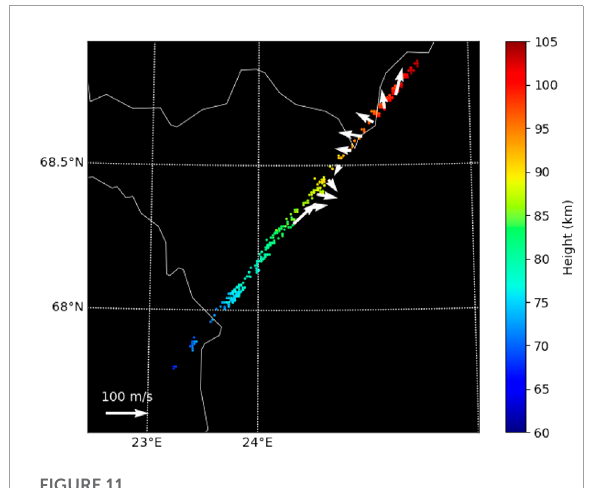
FIGURE 11 The horizontal wind estimated from the long-lasting trail echo, overlaid on the locations of the trail map. The color indicates the trail echo height, and the white arrows indicate the magnitude and direction of the horizontal wind velocity estimated from the trail echo Doppler shifts observed with the Andenes and Sodankylä radars. Note that the deformation of the meteor trail shown in Figure 9 is in agreement with these